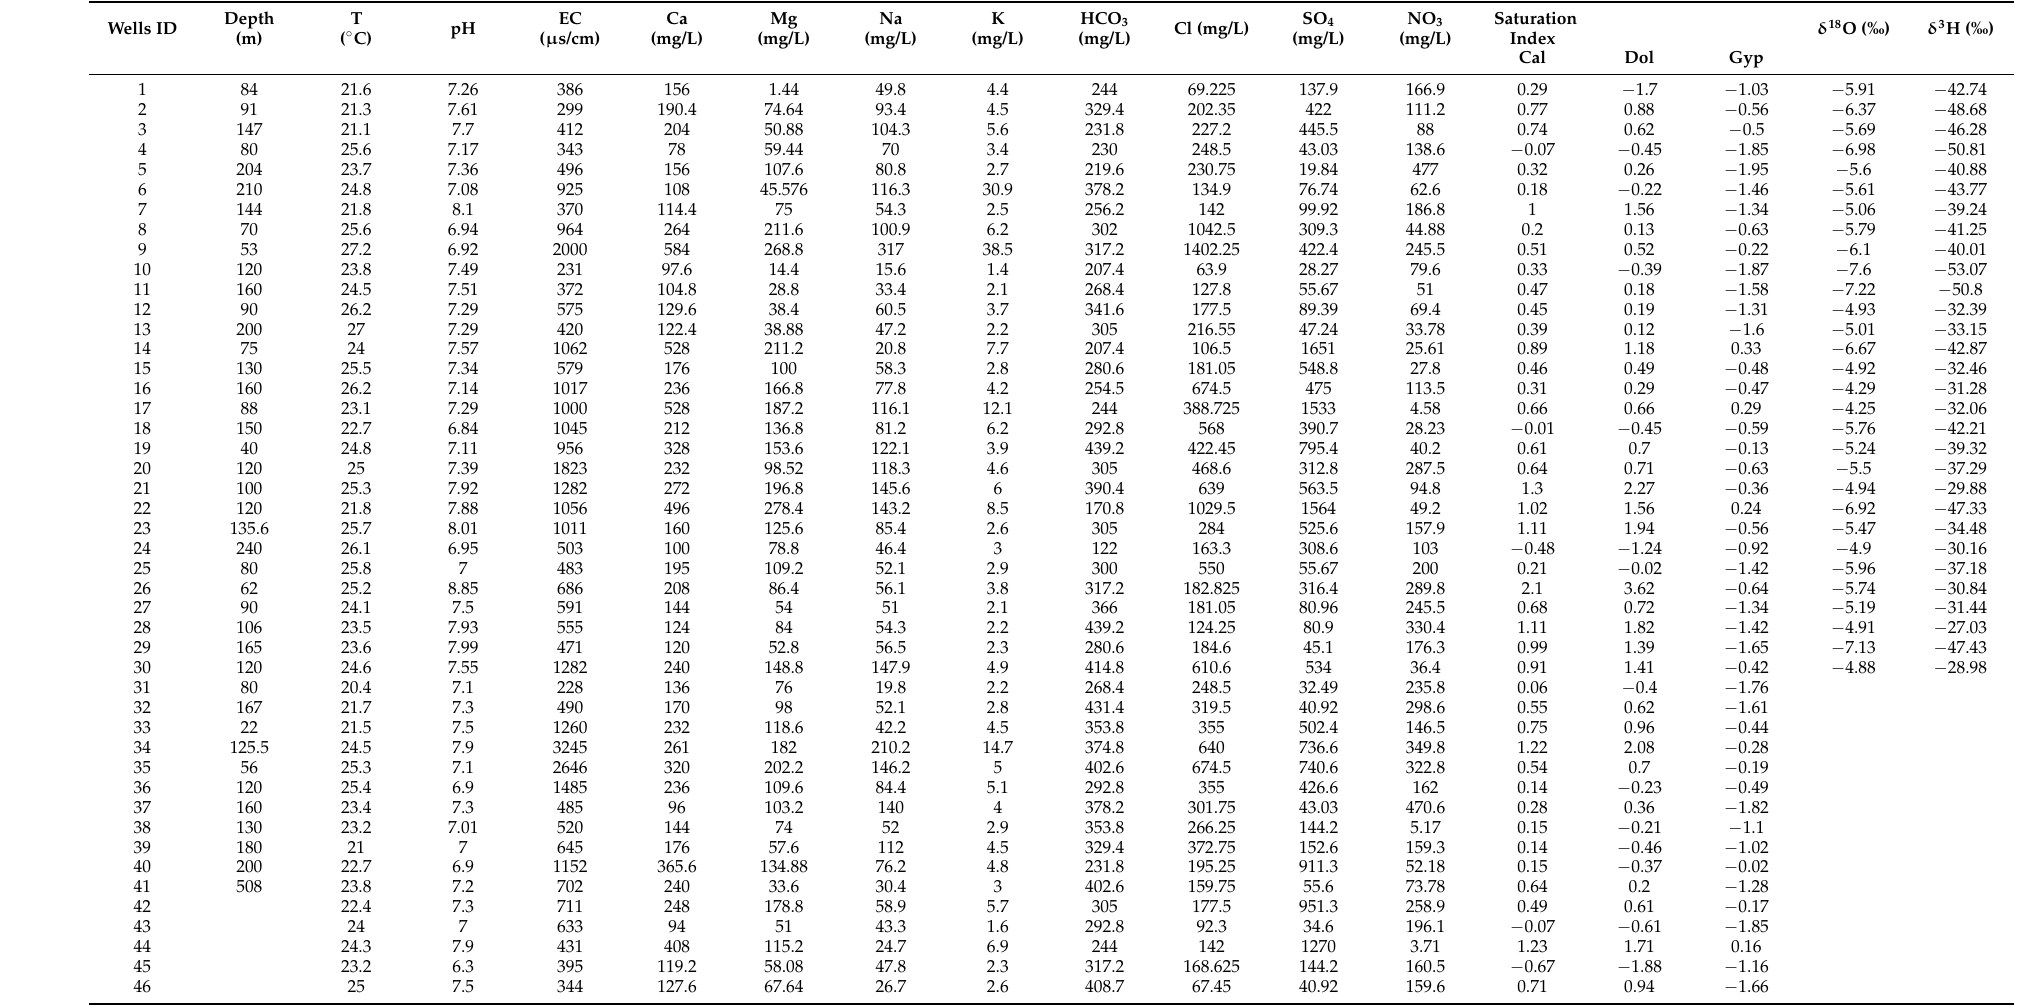
Table 1. Hydrochemical and isotopic values of collected samples from OuleBouSbaa plain,